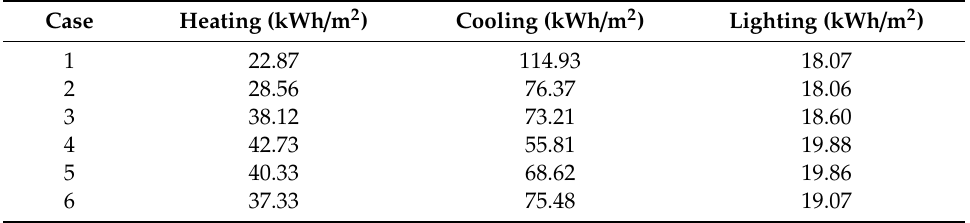
Table 5. Annual energy demands for the di ff erent window cases in